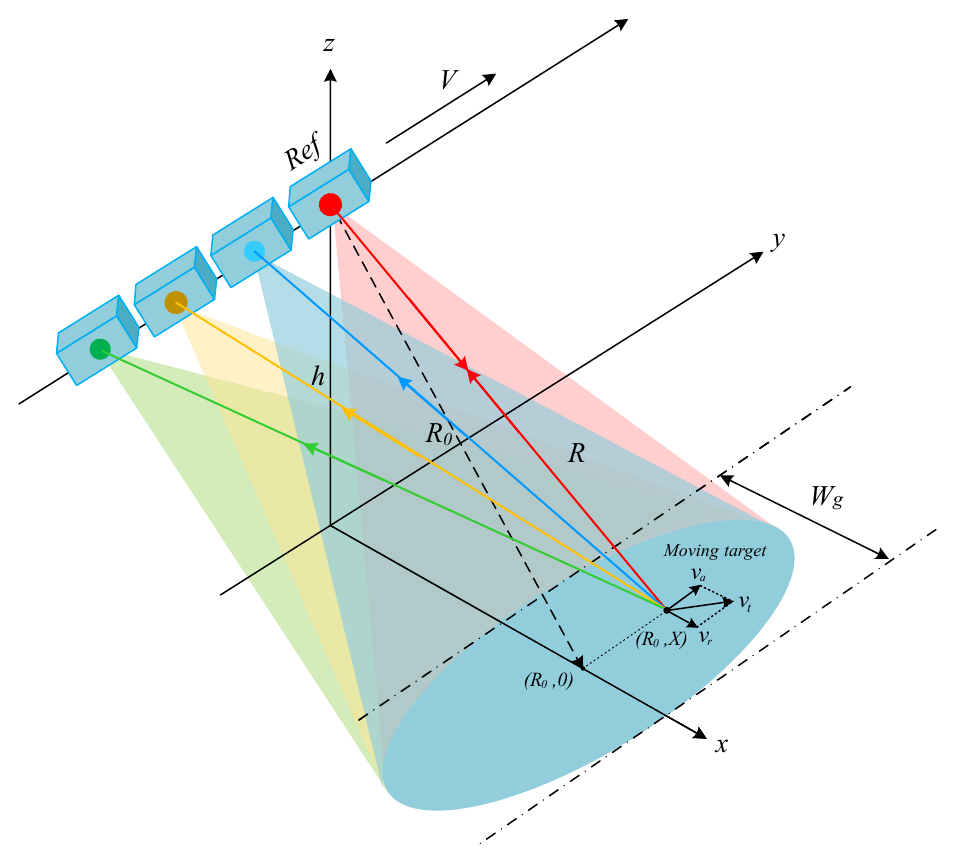
Figure 1. Geometry of multichannel HRWS